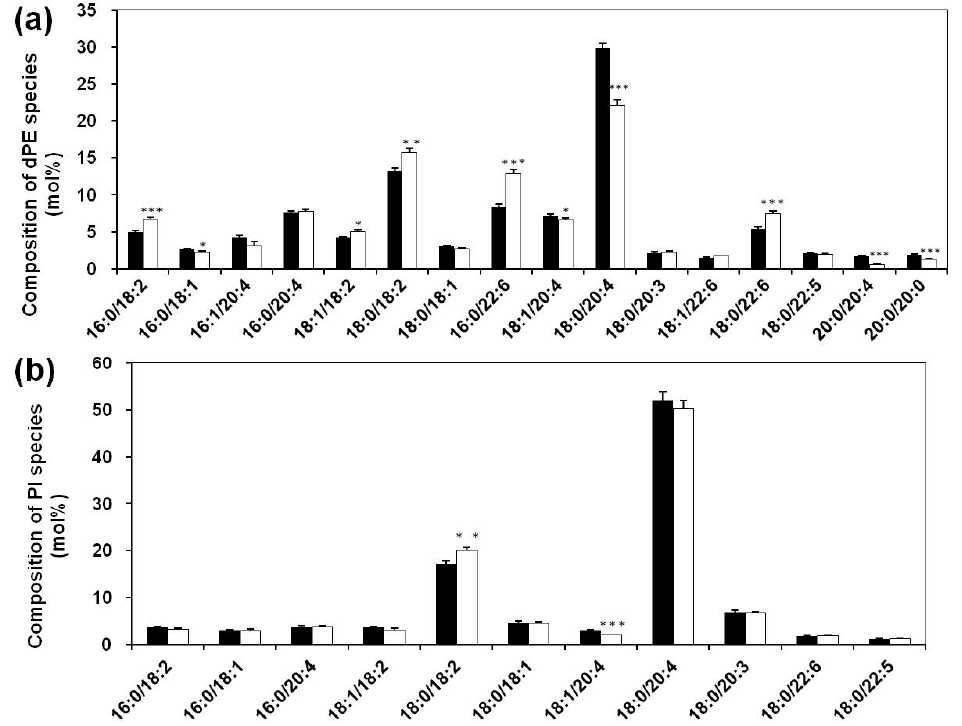
Figure 1. Comparison of the compositions of phosphatidylethanolamine (dPE) and phosphatidylinositol (PI) species present in serum between systemic lupus erythematosus (SLE) patients and healthy controls. Serum lipid extracts from SLE ( N = 30, open bar) and control ( N = 30, solid bar) groups were prepared by using a modified Bligh and Dyer extraction protocol as described in Section 2. The data represented mean ± standard error of mean (SEM) ( N = 30 per group) from different peoples. * p < 0.05, ** p < 0.01, *** p < 0.001 compared with controls.